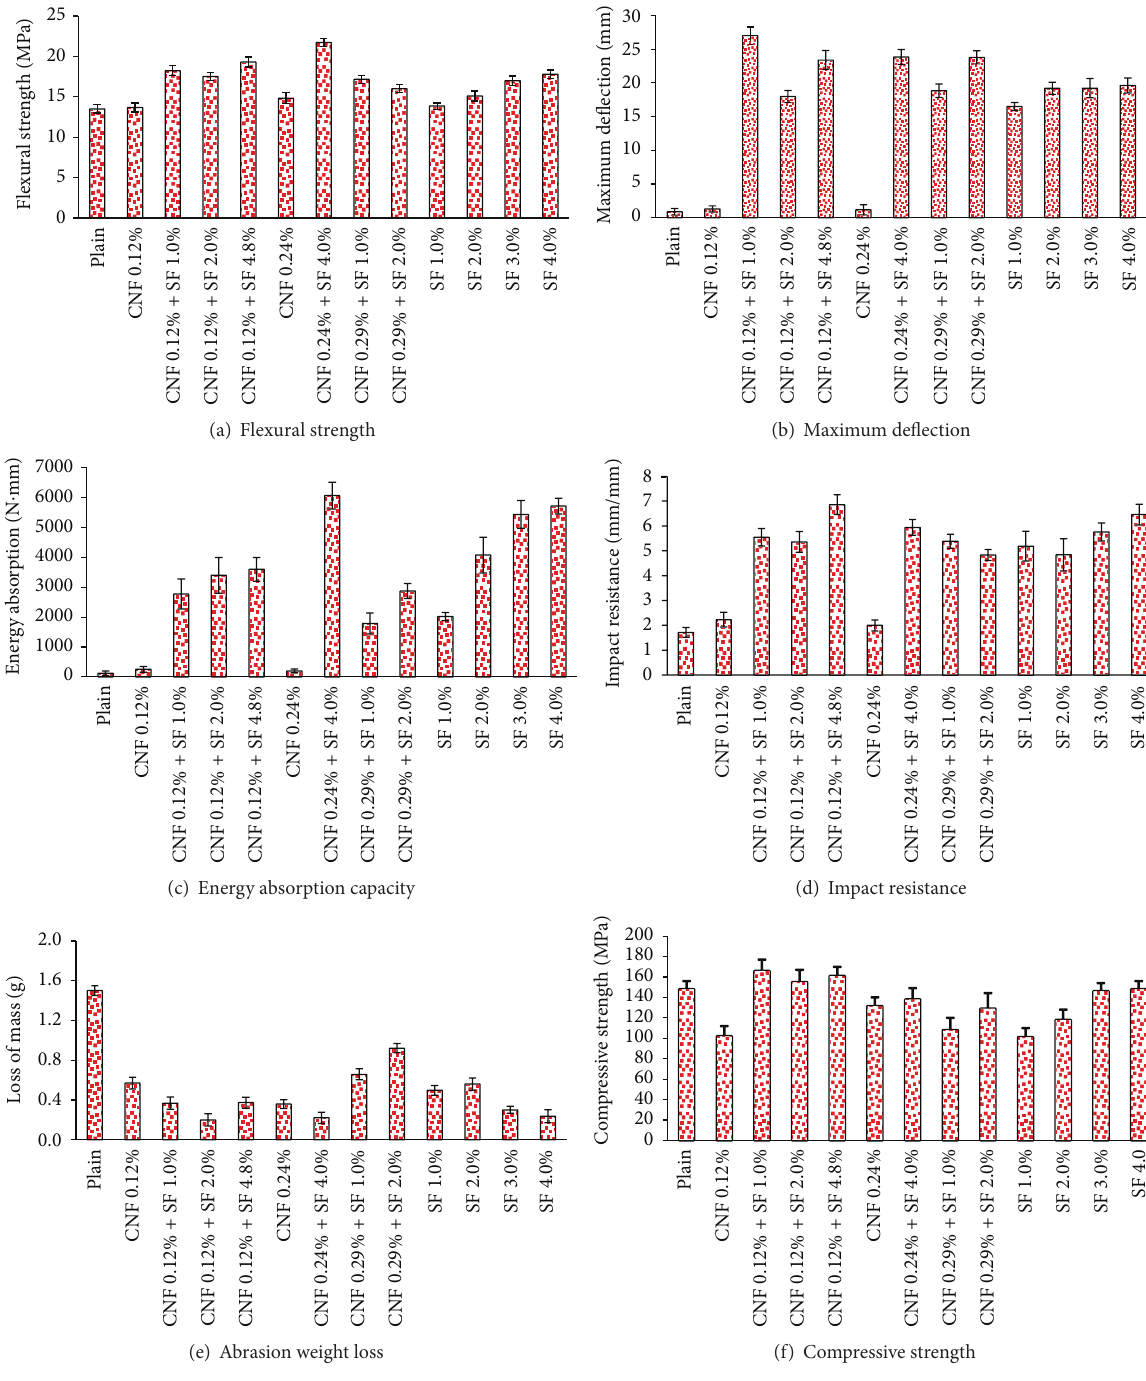
Figure 7: Experimental results on hardened ultrahigh performance concrete material properties (CNF: carbon nanofiber, SF: steel fiber) (means & standard